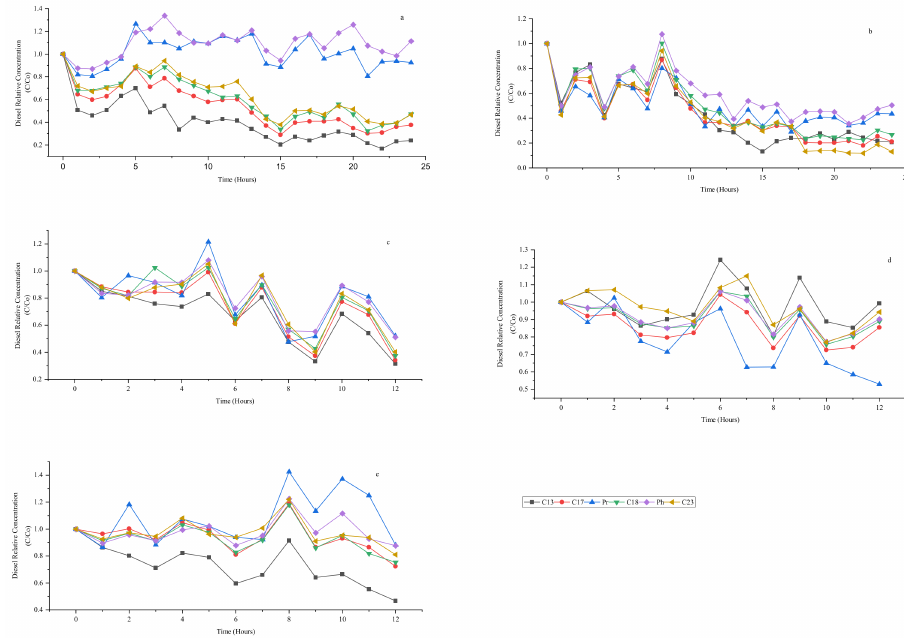
Figure 6. Change of relative concentration of specific hydrocarbons after treatment, Batch 1 ( a ), Batch 5 ( b ), Batch 3 ( c ), Batch 2 ( d ), and Batch 4 ( e